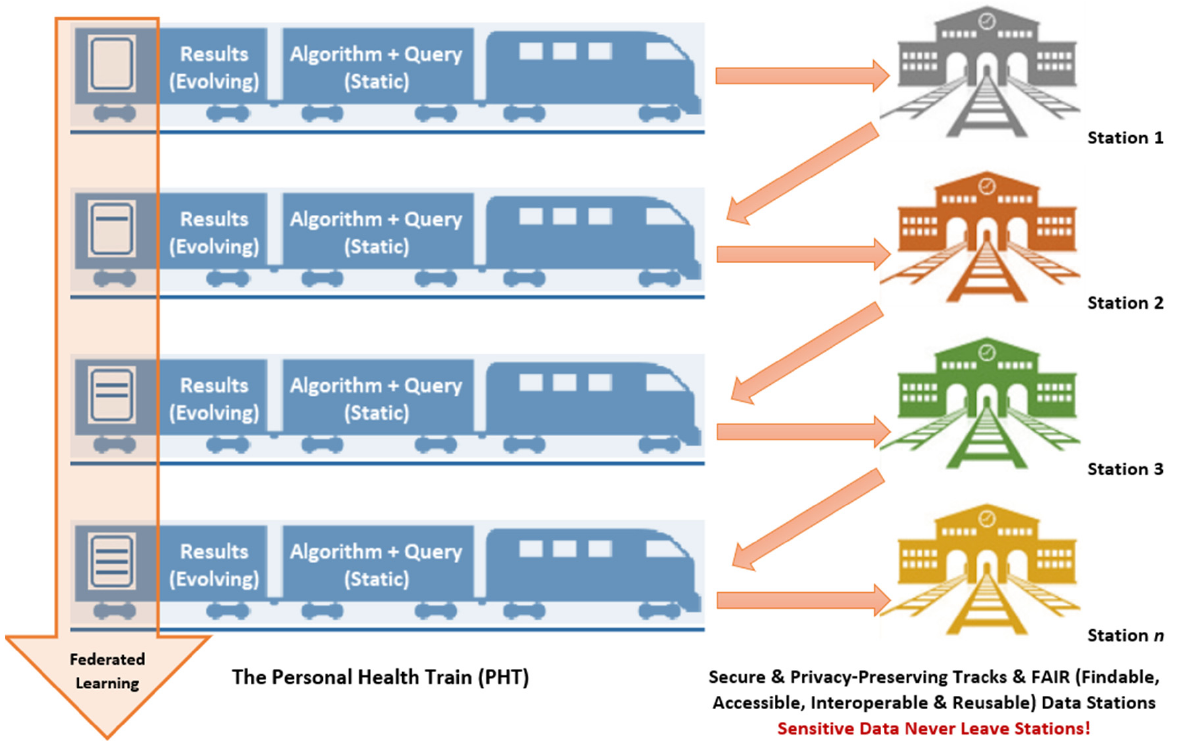
Figure 2. Key components of a PHT environment. Data owners control what a visiting ‘train’ is allowed to do with their data. Each ‘data station’ implements its own set of house rules that define what ‘trains’ can do whilst visiting. ‘Stations’ can range from very large databases to small personal lockers containing the data of one individual. Note how federated learning from data evolves as the ‘train’ (research question) moves from one ‘data station’ to the next.